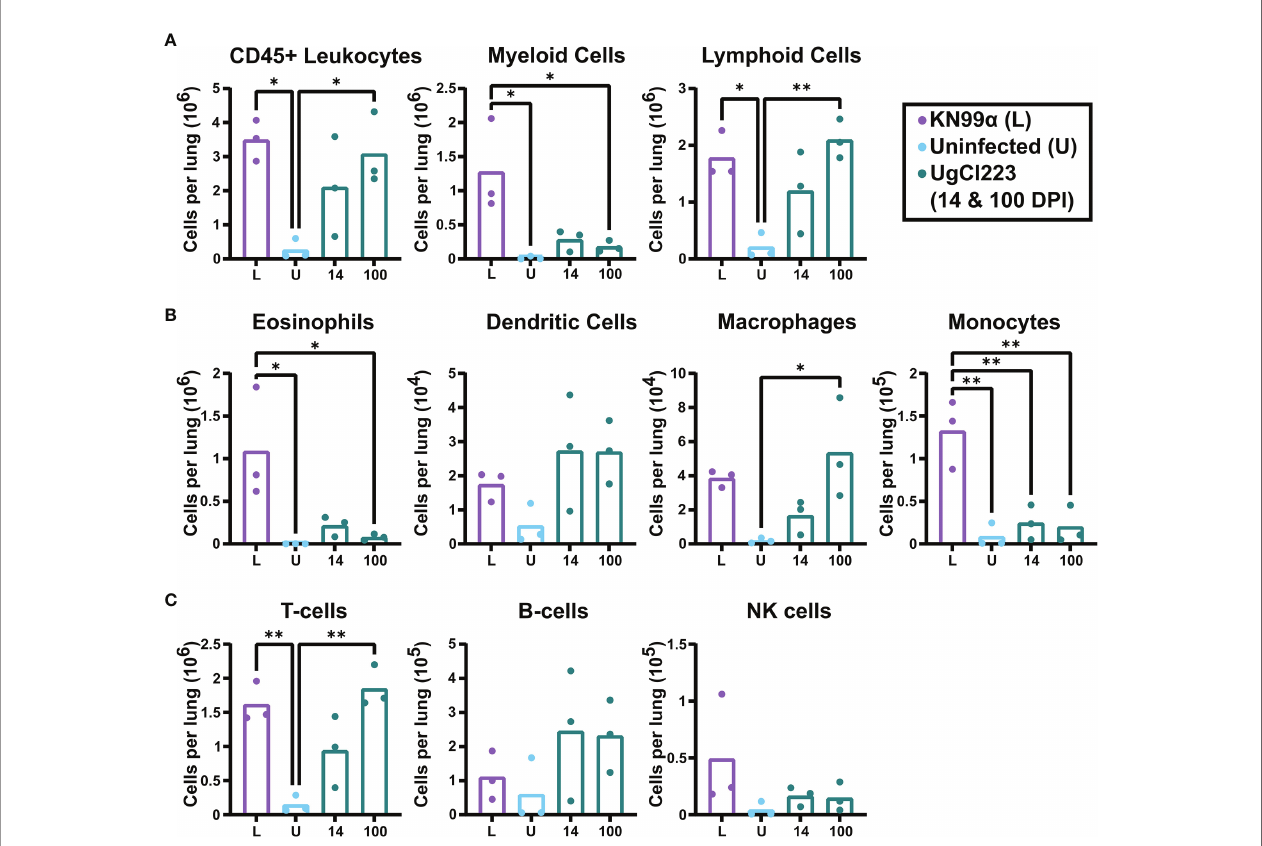
FIGURE 4 | Lymphoid cells were the predominant immune cell in the lungs of UgCl223-infected mice. C57BL/6 mice were intranasally infected with UgCl223 or KN99 a (lethal infection). For UgCl223, single cell lung suspensions were generated at 14- and 100-days post-infection. For KN99 a , single cell lung suspensions were generated at 14-days post-infection. (A) Leukocyte, (B) lymphocyte, and (C) myeloid cell populations were quanti fi ed using fl ow cytometry. L = KN99 a lethal infection at 14-days post-infection; U = uninfected control; 14 = UgCl223 infection at 14-days post-infection; 100 = UgCl223 infection at 100-days post-infection. The gating strategy is shown in Supplementary Figure 1 . In brief, cells were identi fi ed as the following: Eosinophils = CD11b+CD24+SiglecF+, Dendritic Cells = CD11c+CD11b+/-CD24 +MHCII+CD24-, Macrophages = CD64+CD24-, Monocytes = CD11b+Ly6C+/-MHCII-, T-cells = CD11b-CD11c-CD24-MHCII-, B-cells =